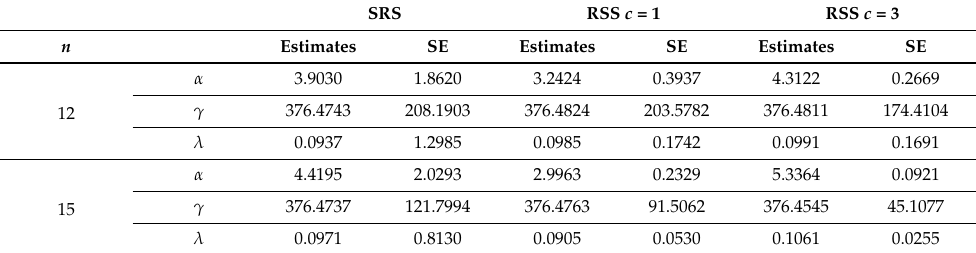
Table 12. MLE for SRS and RSS of the flood data.